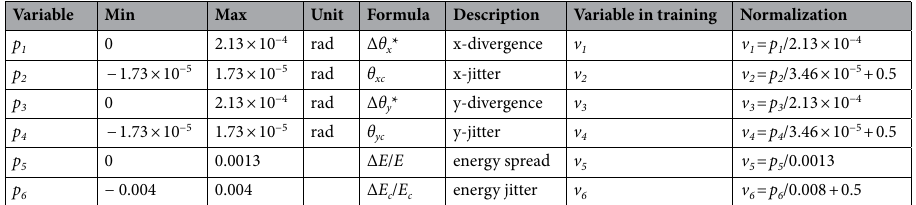
Table 1. The training variables v 1 , v 2 , v 3 , v 4 , v 5 , and v 6 with respect to electron properties, p 1 , p 2 , p 3 , p 4 , p 5 and p 6 , are listed, including the upper maximum and lower minimum limits for all parameters and the unit conversion between training variables to electron properties with their physical definitions. * When we speak about the divergence as the electron beam property, it means �θ x, y ; when we talk about the peak broadening, the divergence should be converted to the normalized divergence ∆ θ x,y / θ x,y